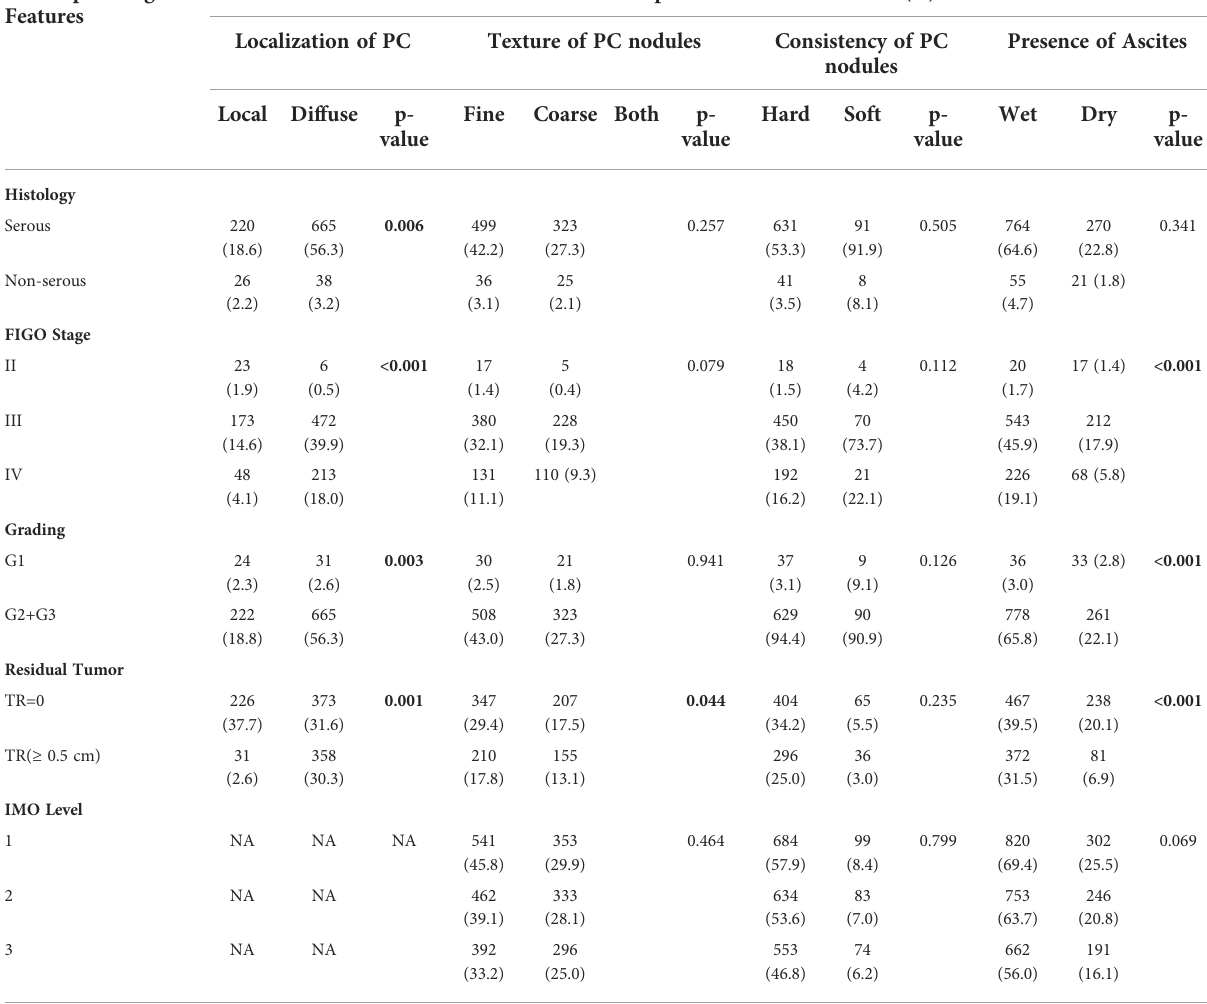
TABLE 3 Correlation of peritoneal carcinomatosis characteristics with clinicopathological features (n=1182). Clinicopathological